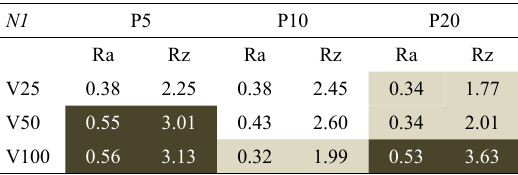
Table 2. Average values of Ra and Rz for each experimental condition after one run N1 (in